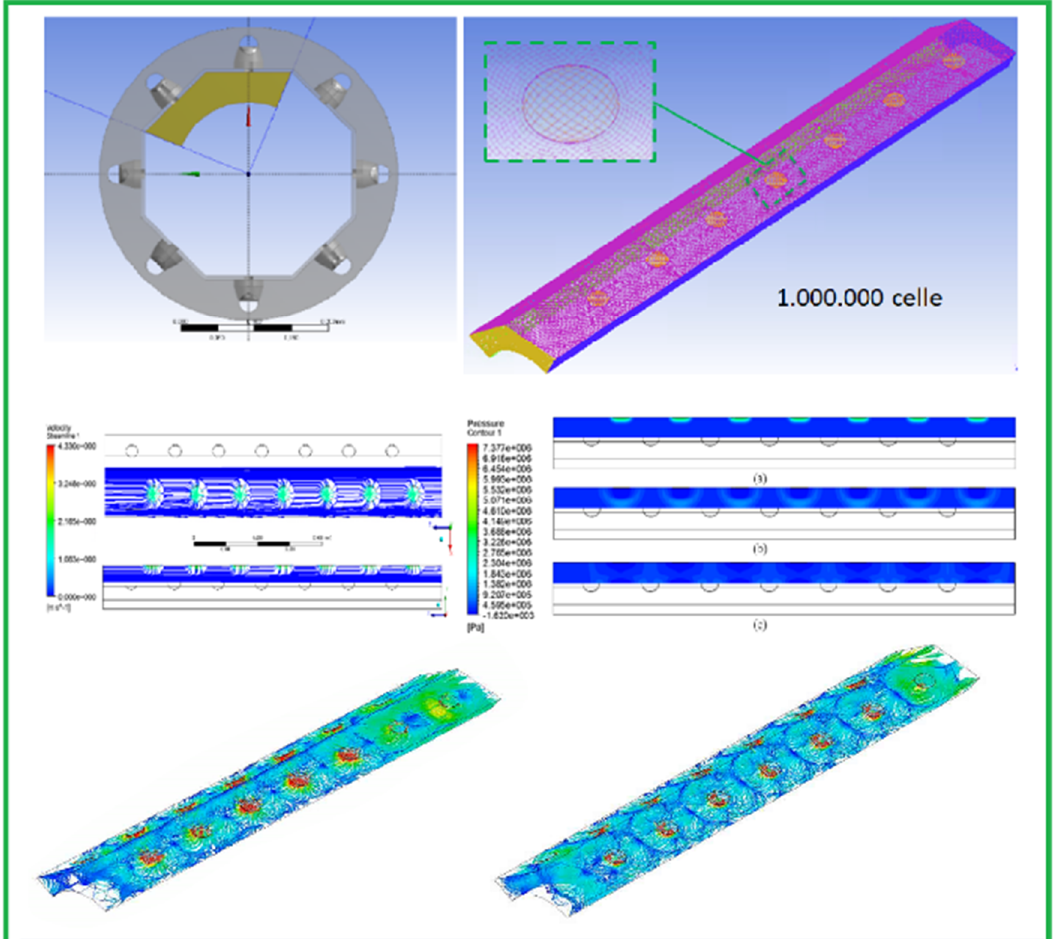
Figure 4. Results of the numerical simulation.